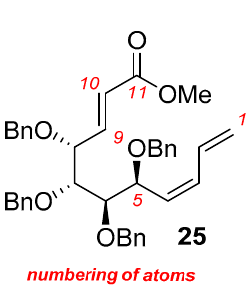
Figure 7. The structure of triene 25 and the numbering of the atoms.